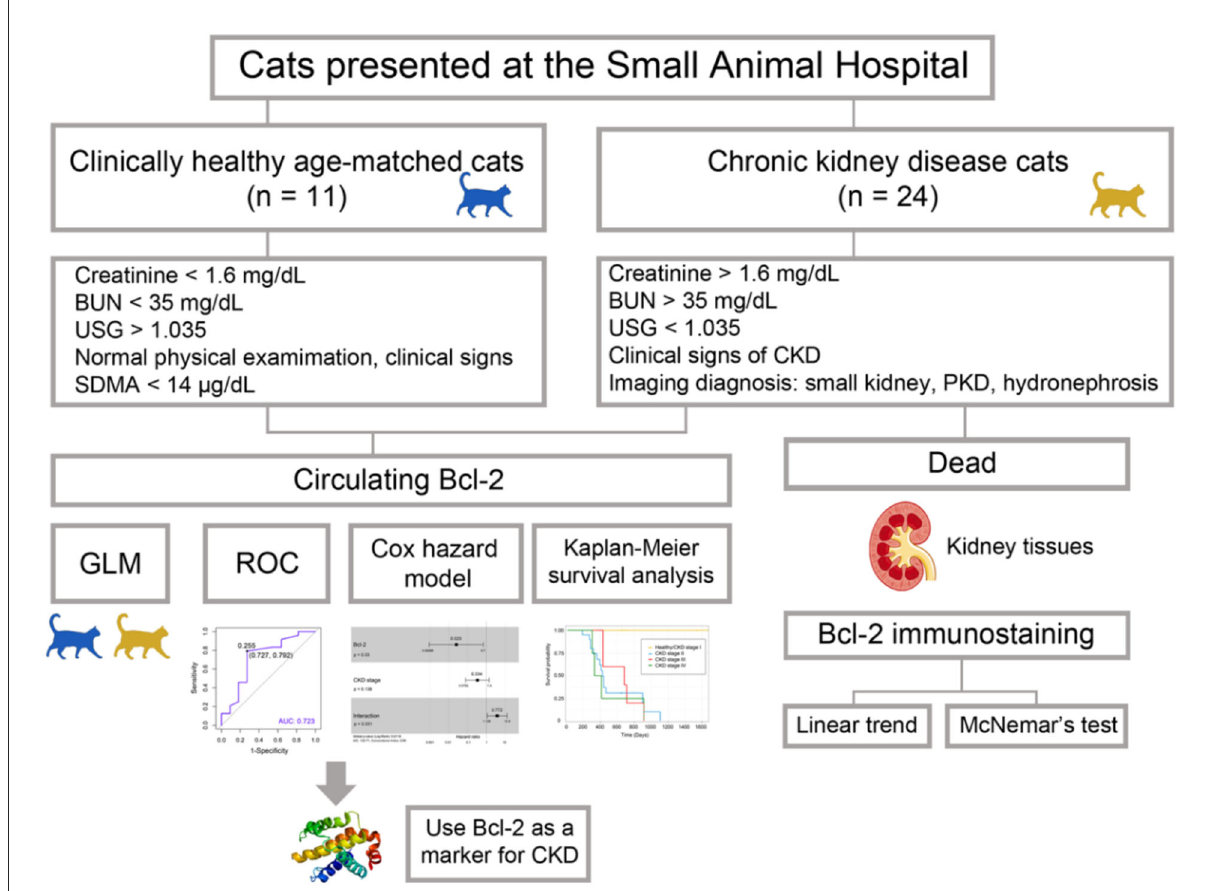
FIGURE1 The workflow of the experiment. The goal of Bcl-2 studies is to determine the efficacy of Bcl-2 as a biomarker in feline chronic renal disease.